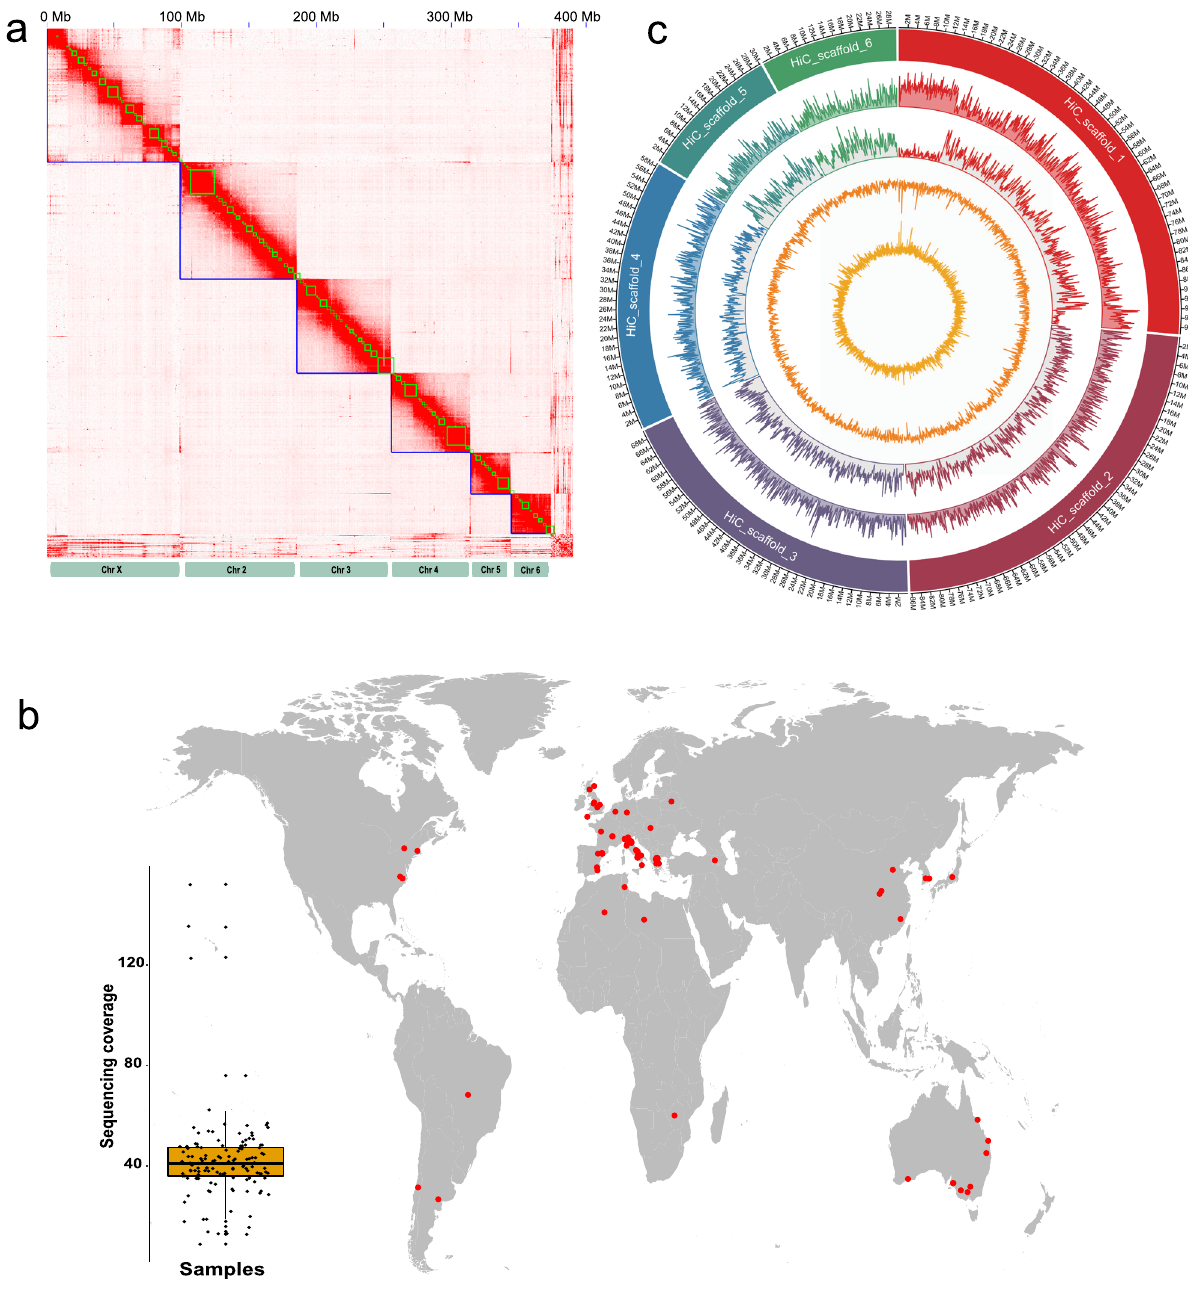
Fig. 1 New biological and genomic resources for the aphid Myzus persicae reveal the genome-wide patterns of genetic variation in clones sampled from across the world. a Chromosome-scale genome assembly of M. persicae clone G006. Heatmap shows frequency of HiC contacts along the genome assembly. Blue lines indicate super scaffolds and green lines show contigs, with the X axis showing cumulative length in millions of base pairs (Mb). b Geographic origin and sequence coverage of the 127 resequenced clones of M. persicae used in this study. c Circular plot of genome-wide genetic variation in a global sample of 127 M. persicae clones. The outermost circle represents the 6 chromosome-sized super-scaffolds of the genome assembly, with scaffold 1 the X chromosome. Moving inwards the circles represent: gene density, SNP density, GC and AT% over 100 kb non-overlapping